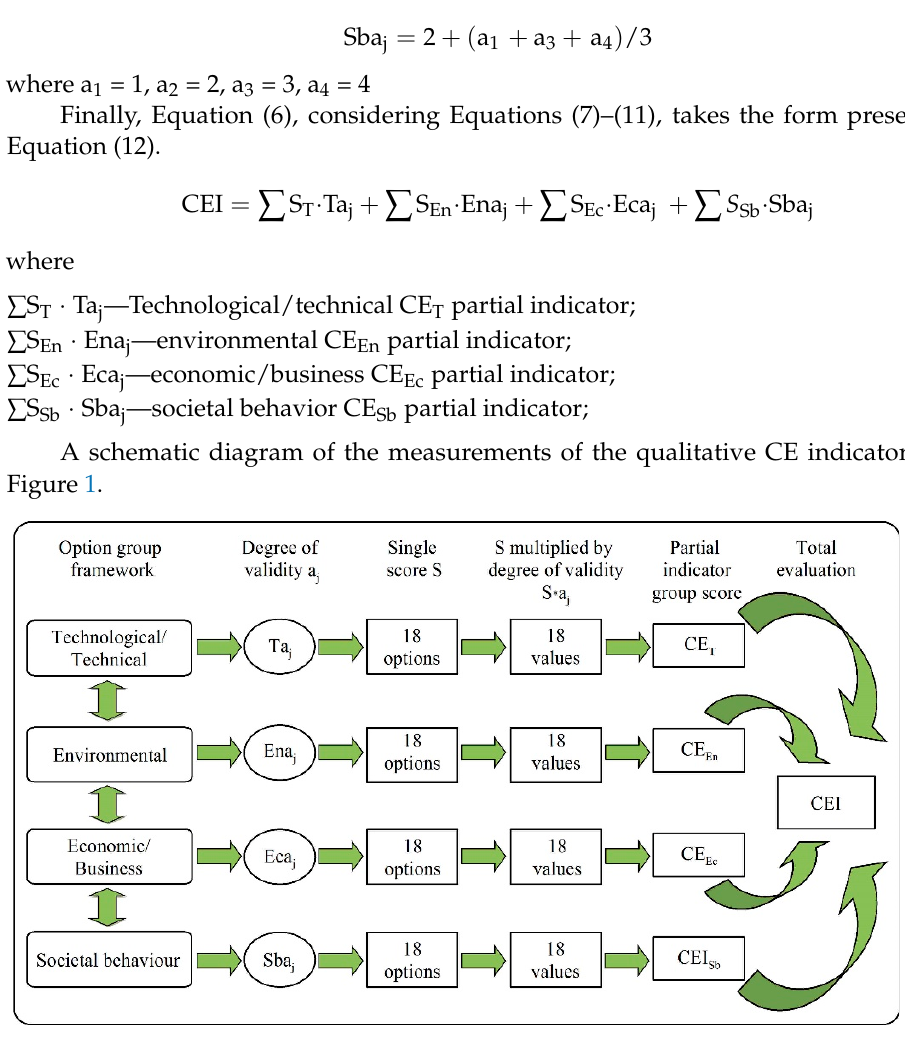
Figure 1. Diagram used to assess the qualitative CE indicator. Ta j = 1 + (a 2 + a 3 + a 4 )/3; Ena j = 4 + (a 1 + a 3 + a 2 )/3; Eca j = 3 + (a 1 + a 2 + a 4 )/3; Sba j = 2 + (a 1 + a 3 + a 4 )/3, where a 1 = 1, a 2 = 2, a 3 = 3, a 4 =